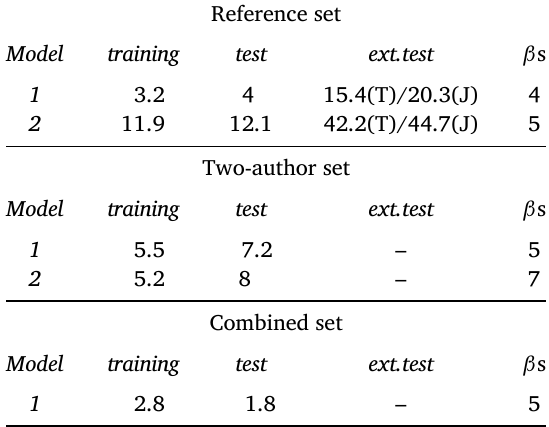
Results for previous work (Klaussner and Vogel 2015), showing RMSE and model size for the reference corpus, the James and Twain data set, and the combination of all three data